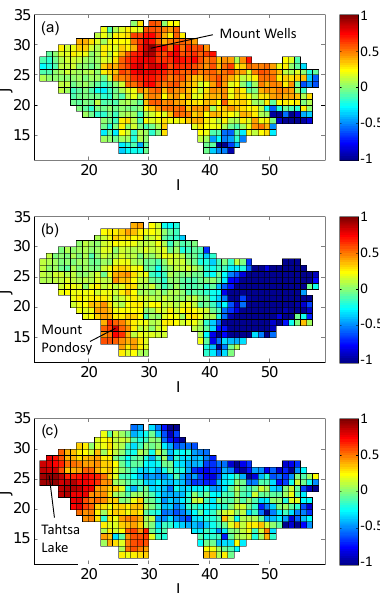
Figure 6. Distribution of the mean square skill score of SWE over the watershed when assimilating SWE located at (a) Mount Wells, (b) Mount Pondosy and (c) Tahtsa Lake. The open loop is used as a reference. Values below − 1 are cut off from the legend.